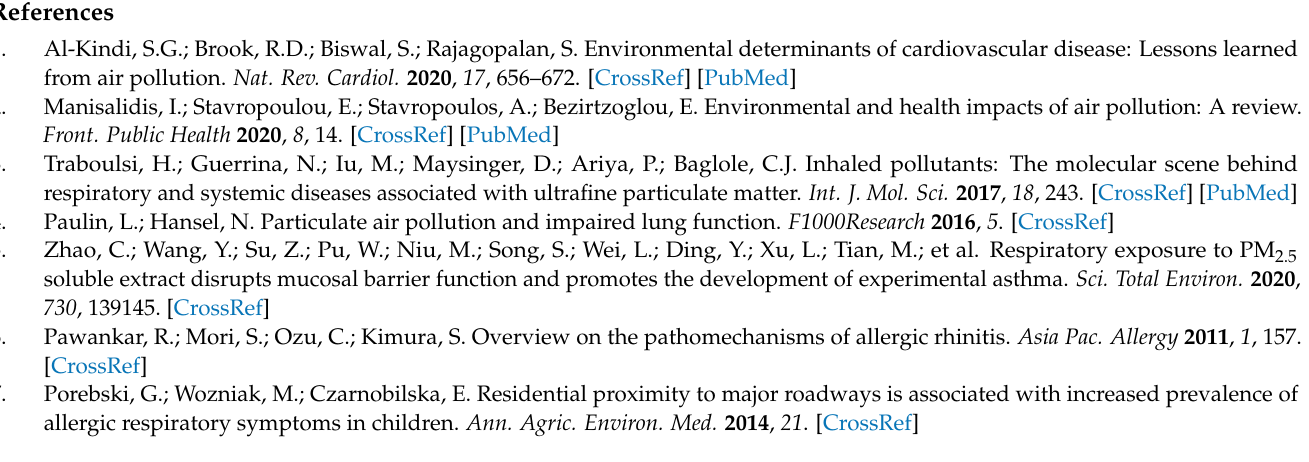
Figure S1: LTA + (gram-positive) EVs gating protocols for plasmatic EVs; LPS + (gram-negative) EVs gating protocols for plasmatic EVs; and CD294 + EVs gating protocols for plasmatic EVs; Figure S2: LPS + (GRAM-negative) EVs gating protocols for plasmatic EVs; Figure S3: CD294+ EVs gating protocols for plasmatic EVs; Figure S4: CD203 + EVs gating protocols for plasmatic EVs; Figure S5: PM 10 and PM 2.5 daily exposure levels; and Figure S6: bNM